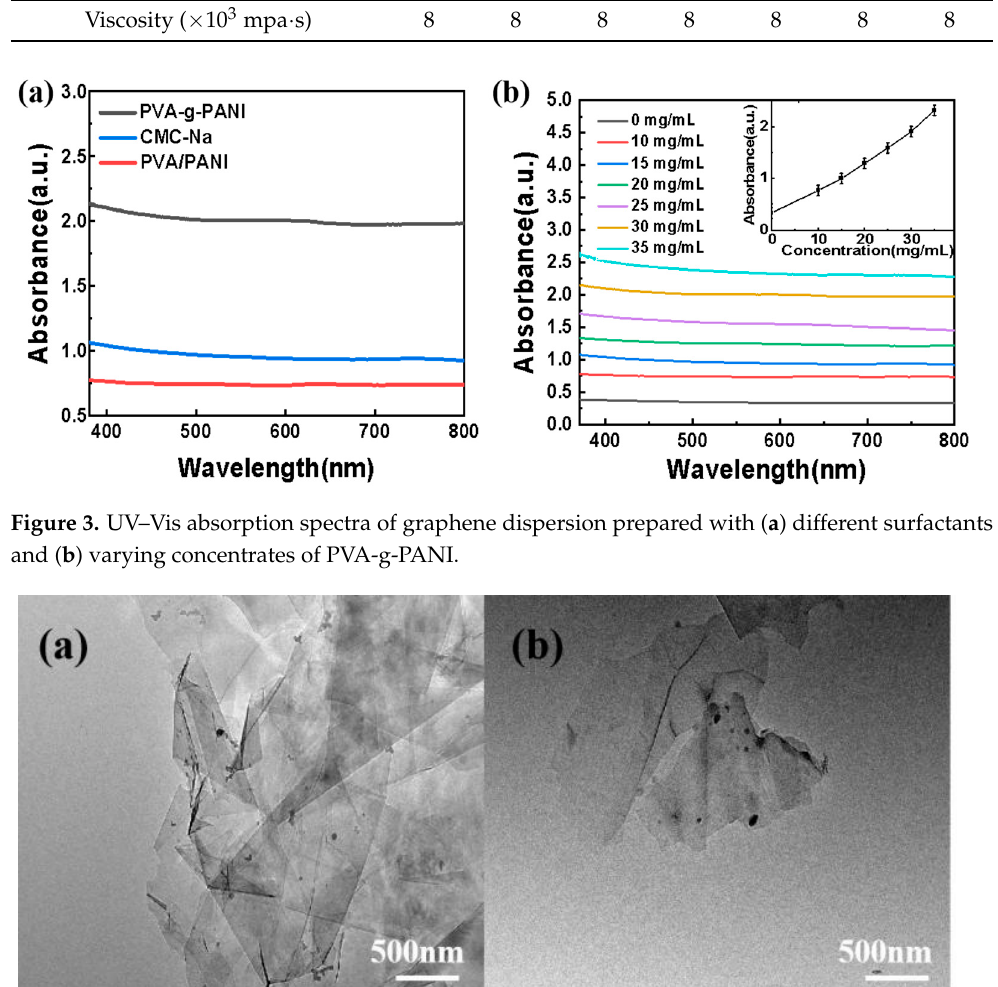
Figure 4. TEM images of ( a ) graphene dispersion and ( b ) graphene dispersion prepared with Figure PVA-g-PANI.